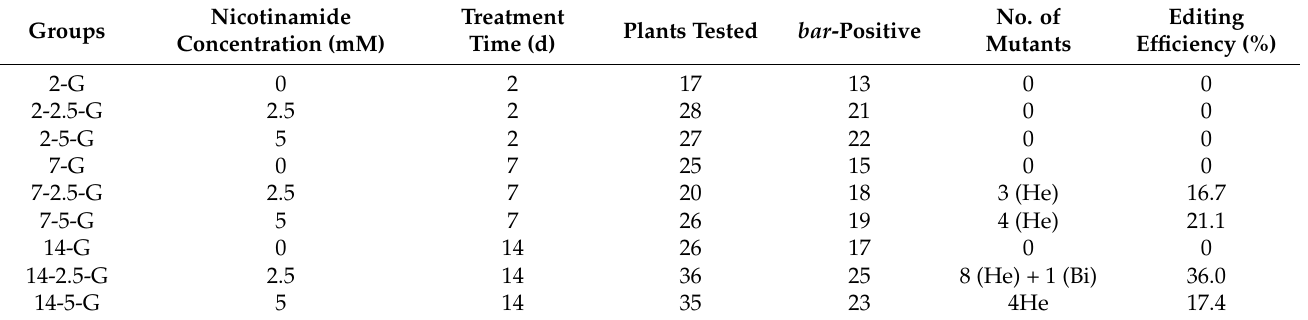
Table 1. The editing efficiency of GUS gene after nicotinamide treatment of immature embryos of the double transgenic parent plants which carry an active GUS gene (homozygous, first transformation) and genome editing vectors (hemizygous, second transformation) in different